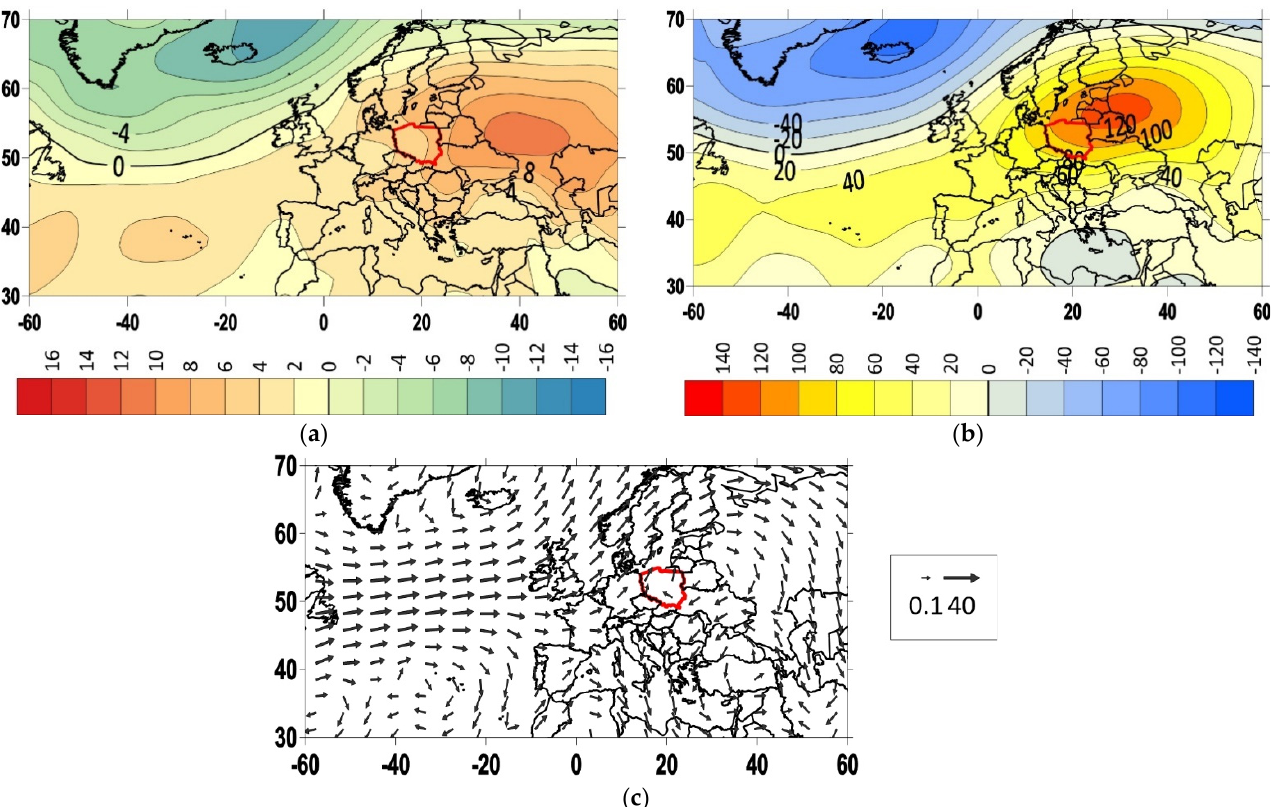
Figure 9. Average fields for the 2006a heat wave: ( a ) anomalies of SLP; ( b ) anomalies of HGT700 mb; ( c ) wind at 700 hPa level. The red line marks the borders of Poland.